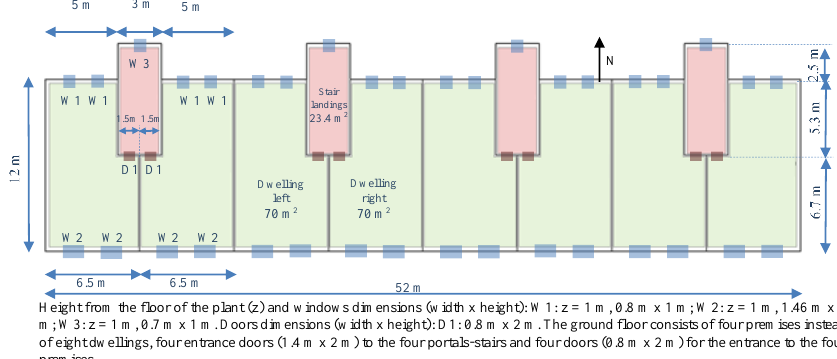
Figure 2. Typical floor plan of the building type. Source: [26].